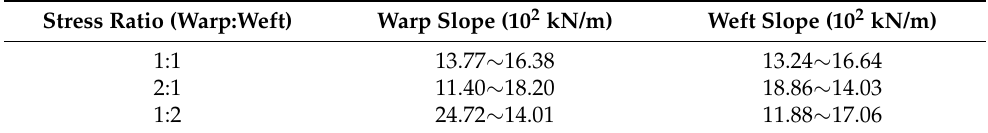
Table 1. The slope range of each curve. Stress Ratio (Warp:Weft)